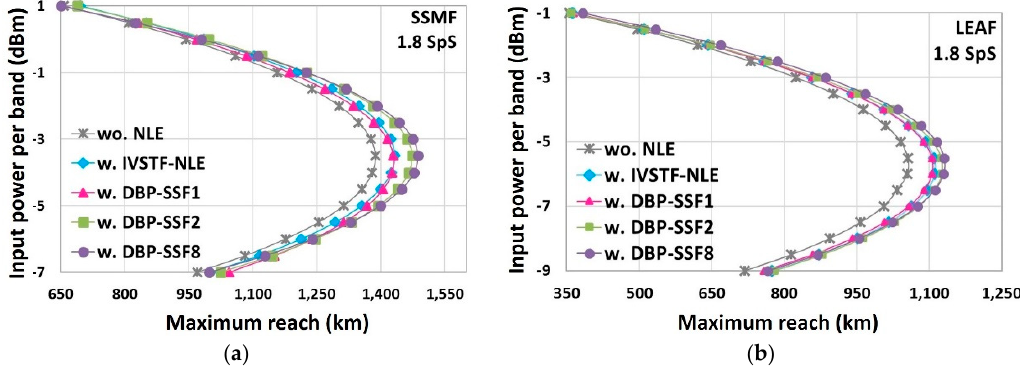
Figure 7. Maximum transmission reach at the FEC limit vs. launch power using IVSTF-NLE and DBP-SSF 1,2,8 NLEs for the 3rd band of the center OFDM super-channel in the simulation case, after signal transmission through ( a ) SSMF and ( b ) LEAF.